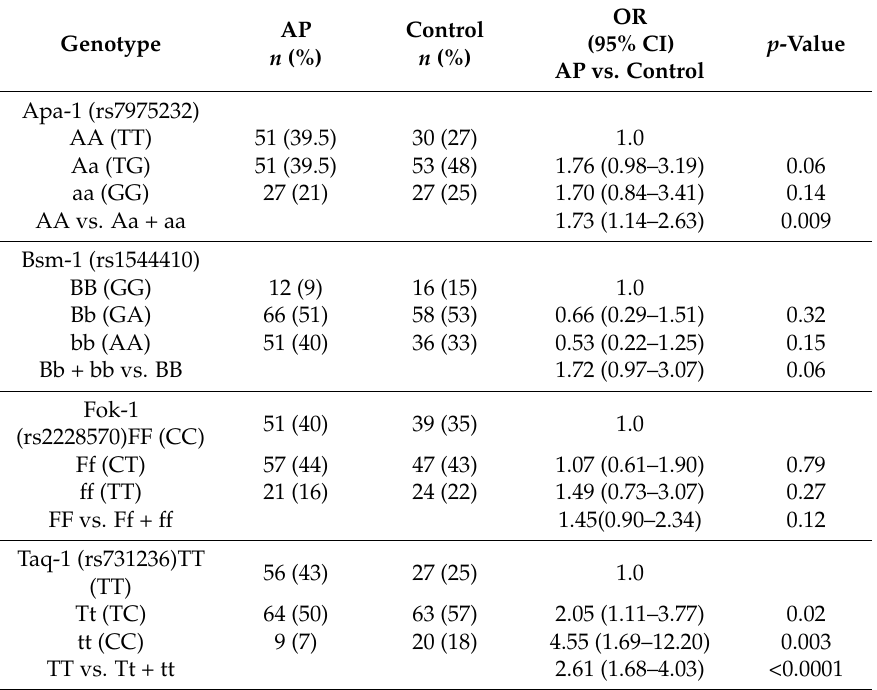
Table 1. Genotype frequencies of Apa-1, Bsm-1, Fok-1, and Taq-1 in VDR gene polymorphisms in the studied groups and the association with AP.